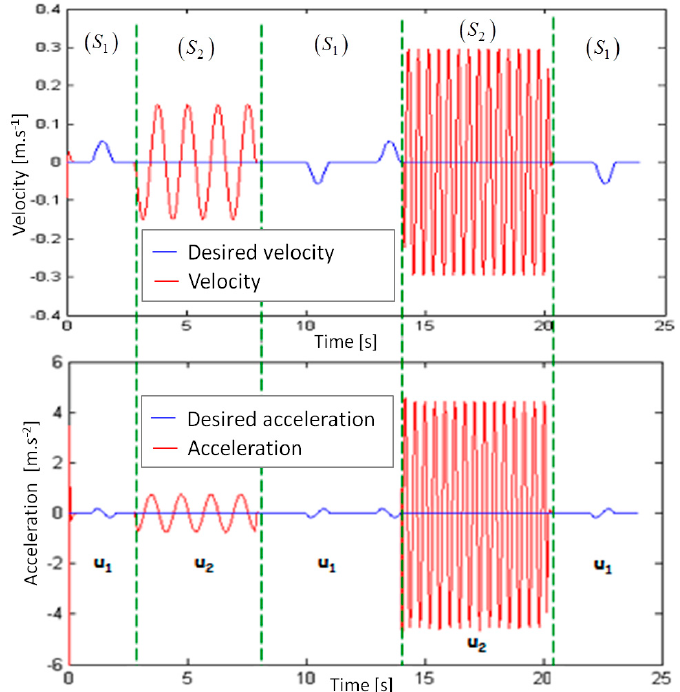
Figure 8. Evolution of the velocity ( upper ) and the acceleration ( below ) with their desired trajec- tories.